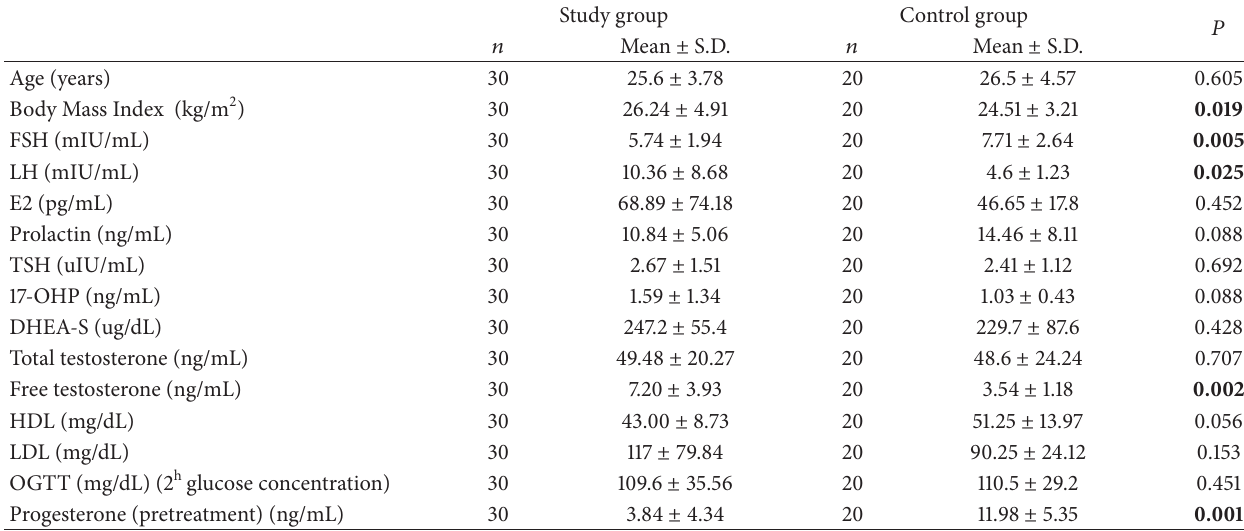
Table 1: Mean distribution of age, BMI, and laboratory values in the study and control groups.